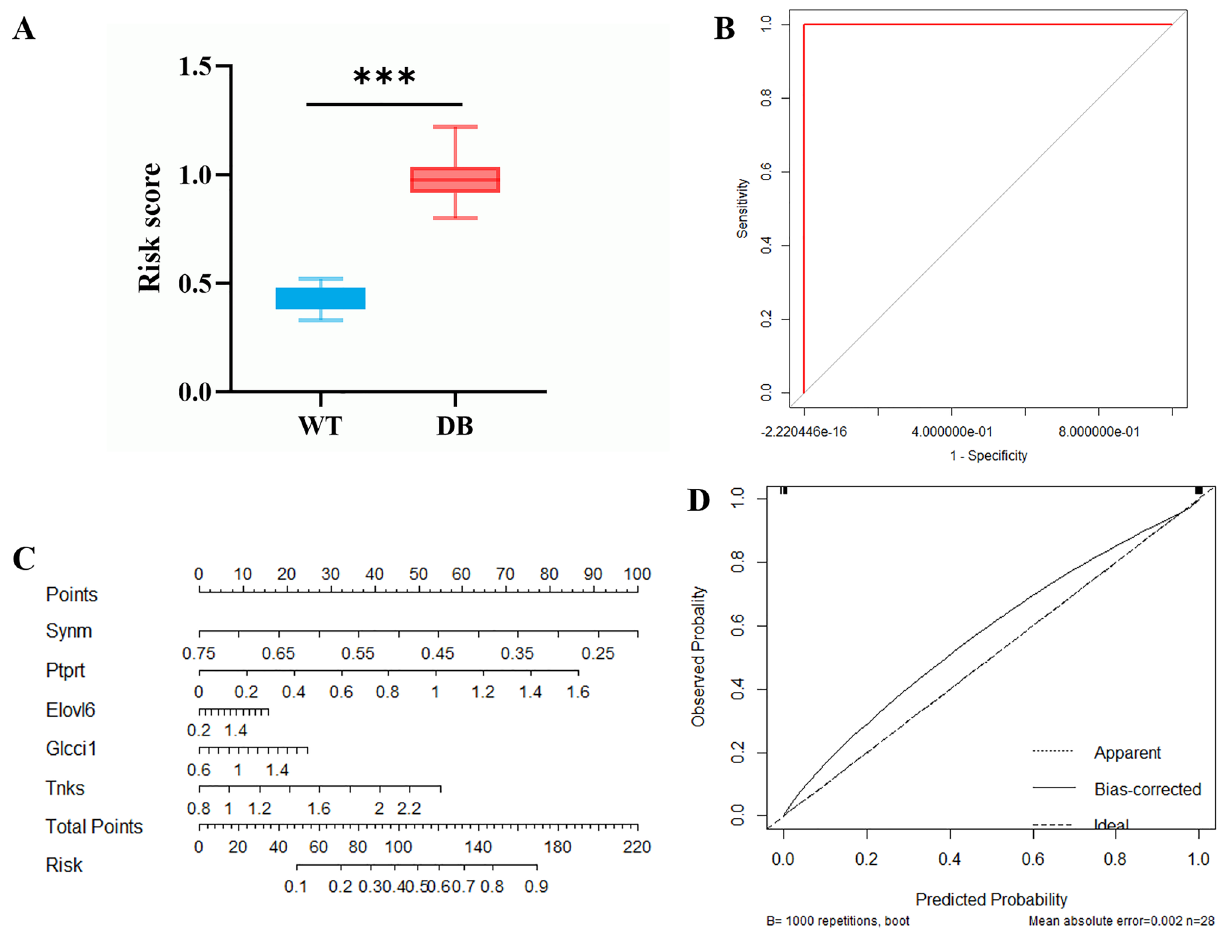
Figure 5. Efficiency of marker genes screened by LASSO model using the training set. ( A ) The high TG-score group had a higher risk of T2DM than the low TG-score group. ( B ) The ROC curve of the marker genes-model. The AUC of the model was 1.000(1.000–1.000). ( C ) The nomogram of LASSO regression. ( D ) The calibration curve of the marker genes-model. The C-index and the robust C-index were 1.000 and 0.999, respectively. *** P <